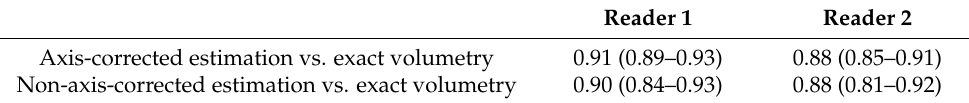
Table 2. Interclass-correlation coefficients (ICCs) for inter-method reliability.